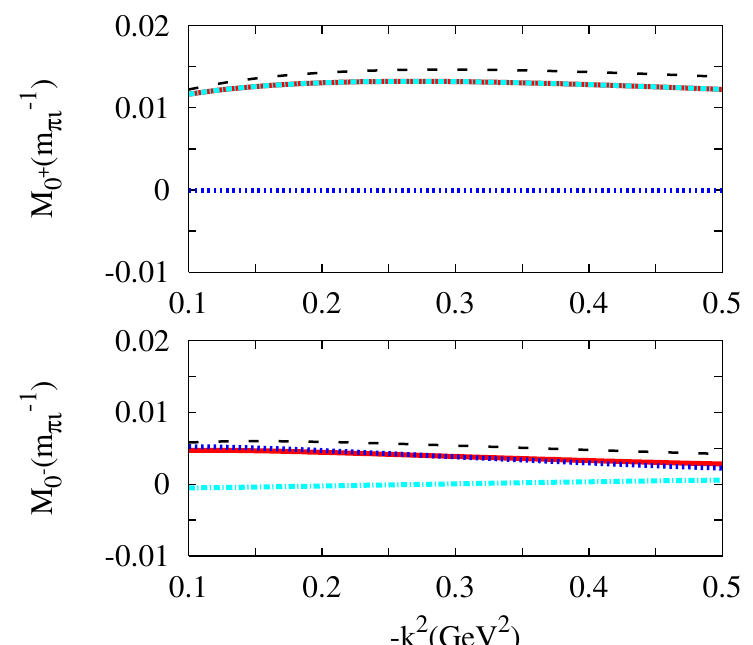
Fig. 1. (Color online) M ( + ) (Upper) and M ( − ) (Lower) amplitude in a unit m − 1 in terms of − k 2 [GeV 2 ]. Dot-dashed π 0 + 0 + (sky-blue) and dotted (blue) curve are contributions by Born and non-Born term, respectively. Solid (red) curves are final results by Eq.(15). Dashed (black) curves are results with µ = 0 limit of Eq.